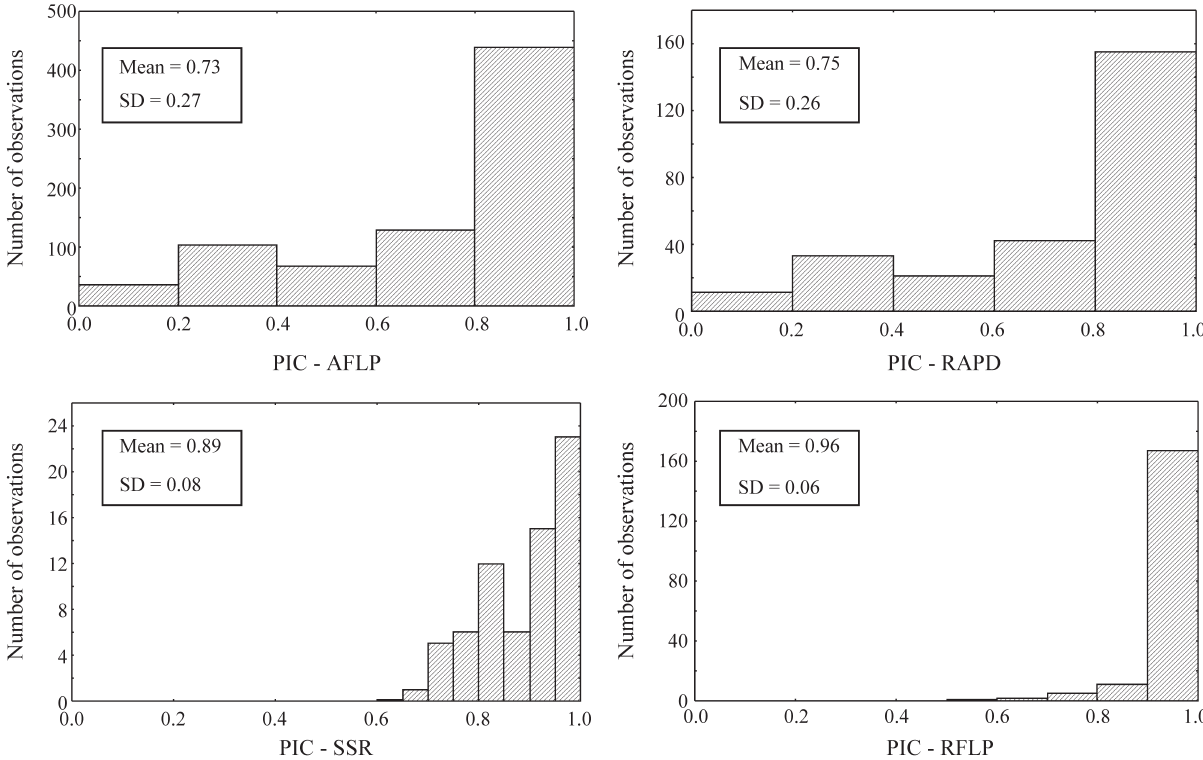
Figure1 -Distributionofpolymorphisminformationcontent(PIC)datafordifferentmaizecrosses.Thedatawasobtainedusingrandomamplifiedpoly- morphic DNA (RAPD), restriction fragment length polymorphism (RFLP), amplified fragment length polymorphism (AFLP) and simple sequence re- peat (SSR) markers. SD= standard